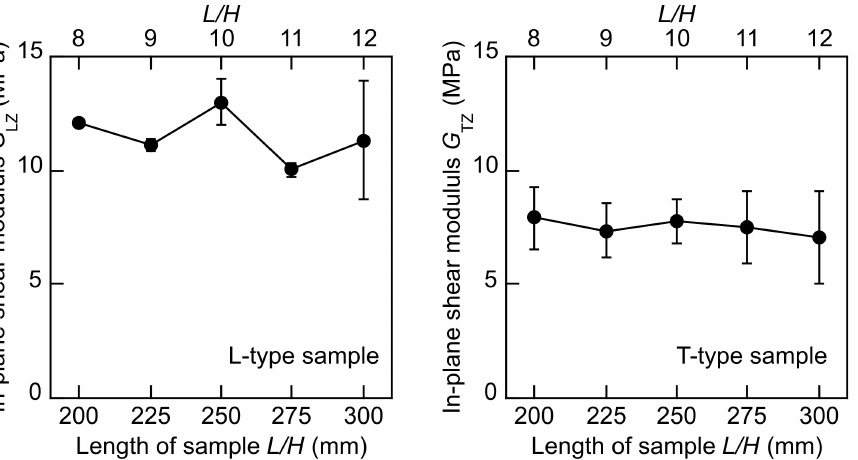
Figure 8. G LZ – L, G LZ – L/H, G TZ – L , and G TZ – L/H relations determined by flexural vibration tests. Results = average ± standard